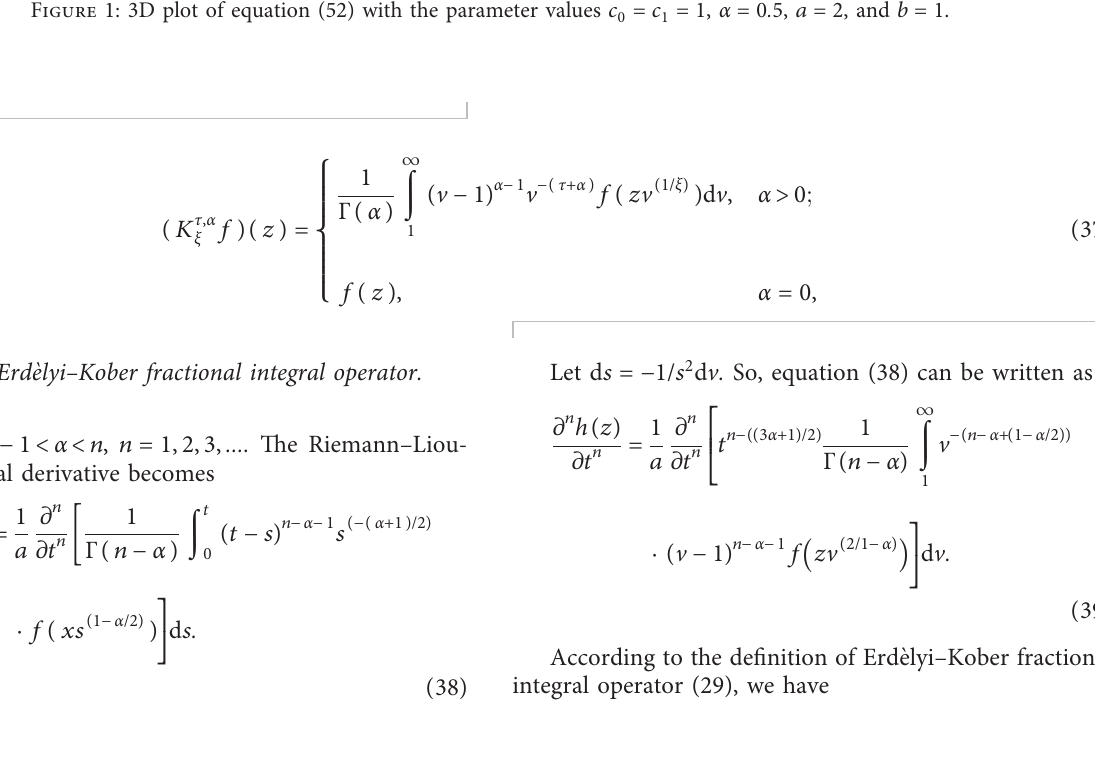
Figure 1: 3D plot of equation (52) with the parameter values c